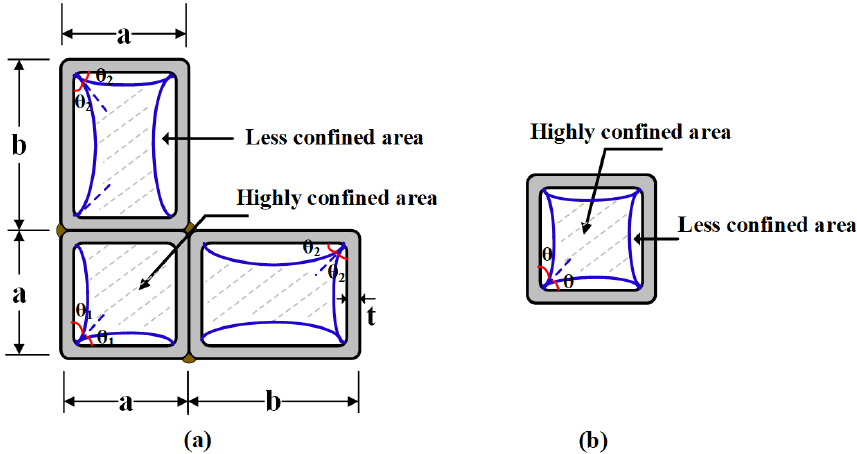
Figure 4. Highly confined areas and less confined areas for ( a ) an ML-CFST section and ( b ) a square section.